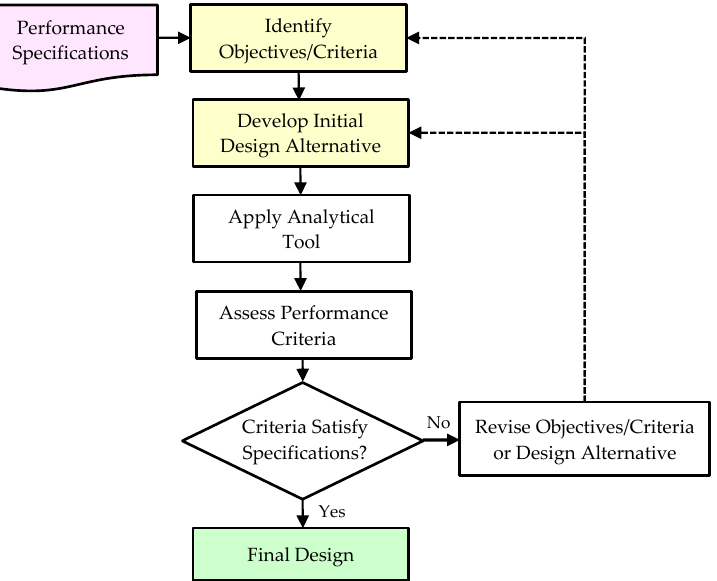
Figure 1. Typical performance-based analysis (PBA)